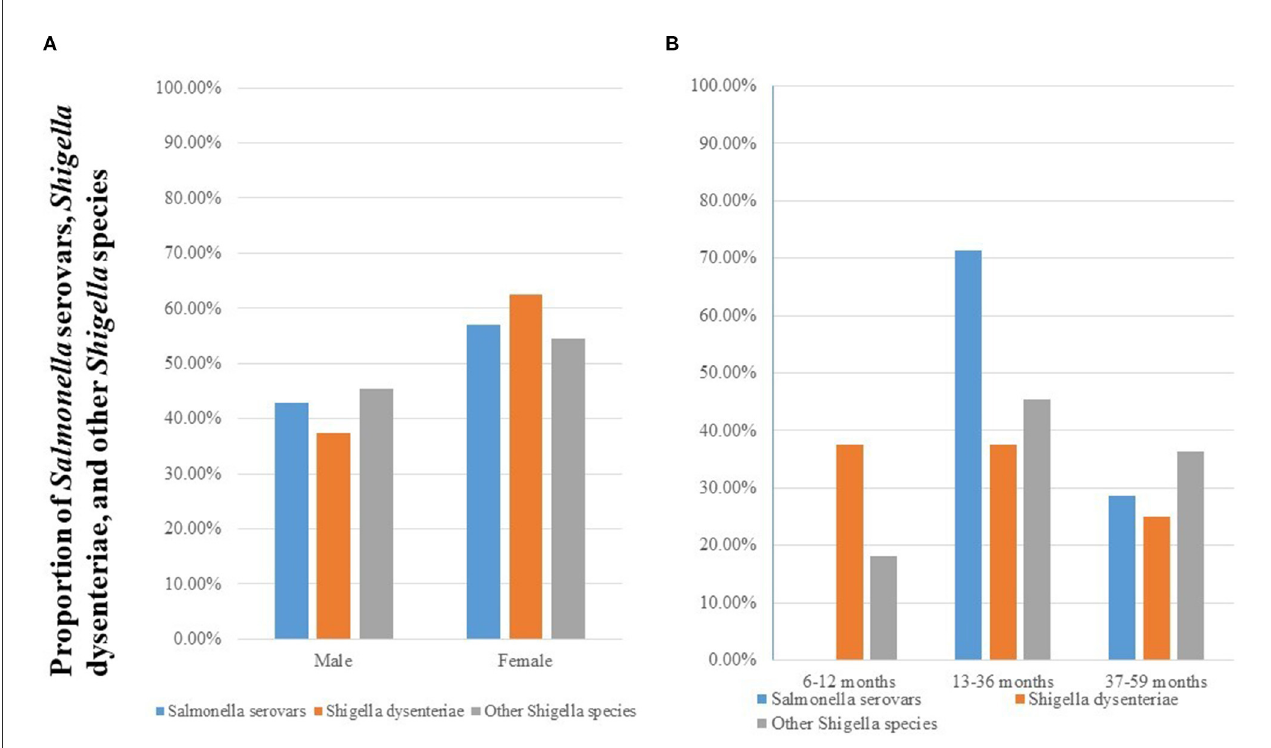
FIGURE2 Prevalence of Salmonella serovars, S. dysenteriae , and other Shigella species stratified by sex (A) and age group (B) among diarrheic under-five children in public health facilities in Debre Markos town, Northwest Ethiopia, 2022.